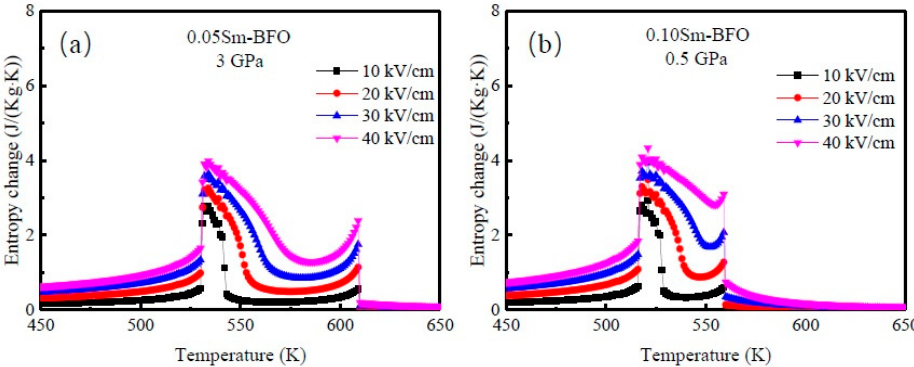
Figure 5. Entropy changes of ( a ) 0.05 Sm-BFO with di ff erent electric fields as a function of temperature under 3 GPa and ( b ) 0.10 Sm-BFO with di ff erent electric fields as a function of temperature under 0.5